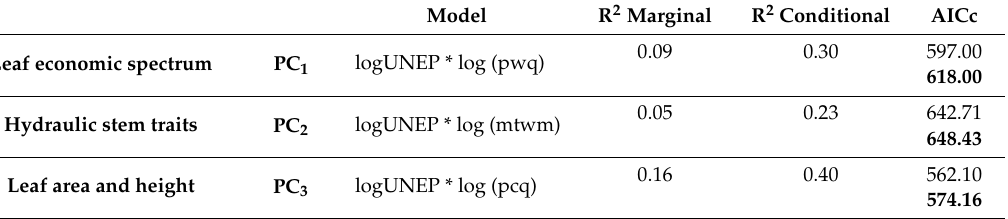
multiplication of